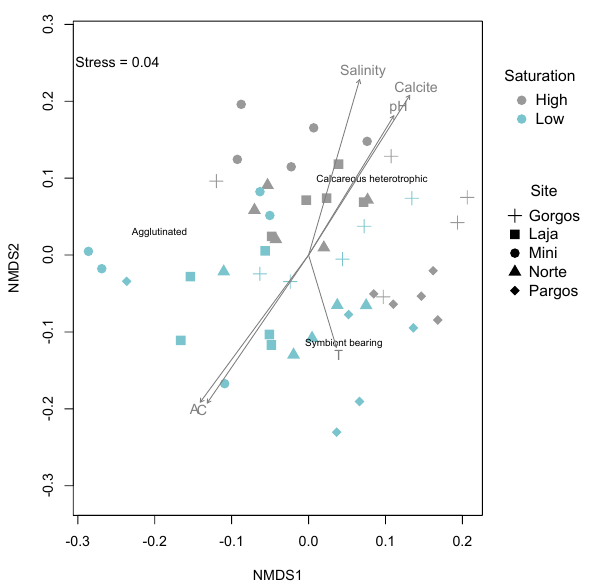
Figure 8. Non-metric multidimensional scaling (nMDS) ordina- tion plot for community structure (relative abundance) by carbon- ate saturation state and site, with overlaid environmental parameters ( A = total alkalinity; C = total inorganic carbon; T = temperature).